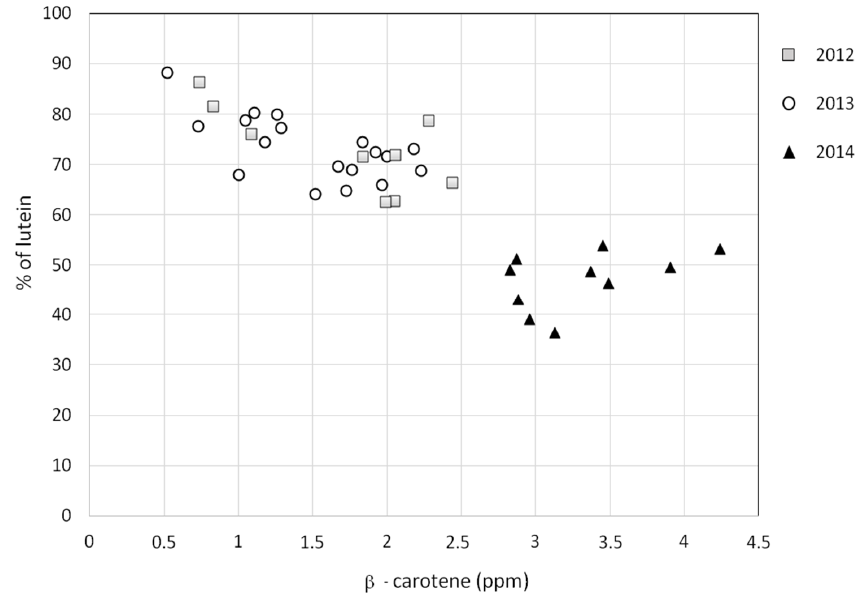
Figure 4. Plot of the parameter “% of lutein” (over the carotenoid fraction) versus the concentration (ppm) of β‐ carotene for the EVOO samples investigated in this work. Samples are labeled according to the harvest year.